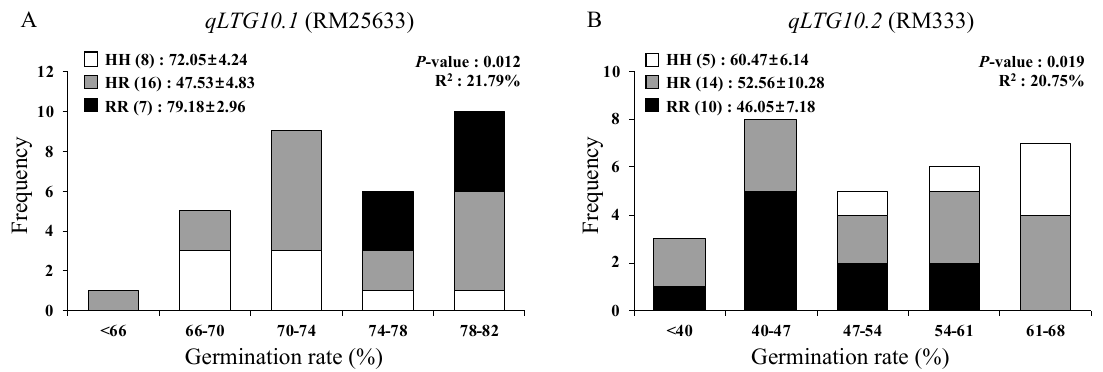
Figure 3. Frequency distribution of LTG at 7 days after incubation in the two F 3 population. Plants in each population are segregating in ( A ) RM25633 for qLTG10.1 and ( B ) RM333 for qLTG10.2 in the different genetic background. The numbers in parenthesis indicate plants number followed by mean germination rate ± standard deviation of genotype group. p -value and R 2 were determined by one-way ANOVA. HH: Hwaseong homozygoutes, RR: O. rufipogon homozygotes, HR: heterozygotes.